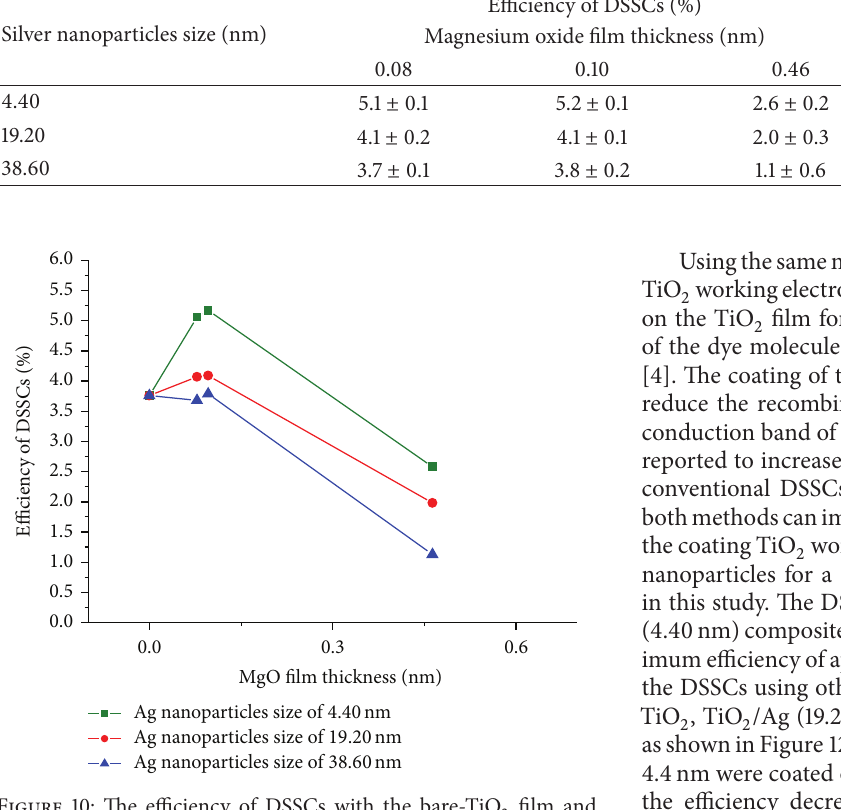
Figure 10: The efficiency of DSSCs with the bare-TiO 2 film and the TiO 2 /MgO (0.10 nm)/Ag composite films with various Ag nanoparticles sizes in range of 4.40–38.60 nm.